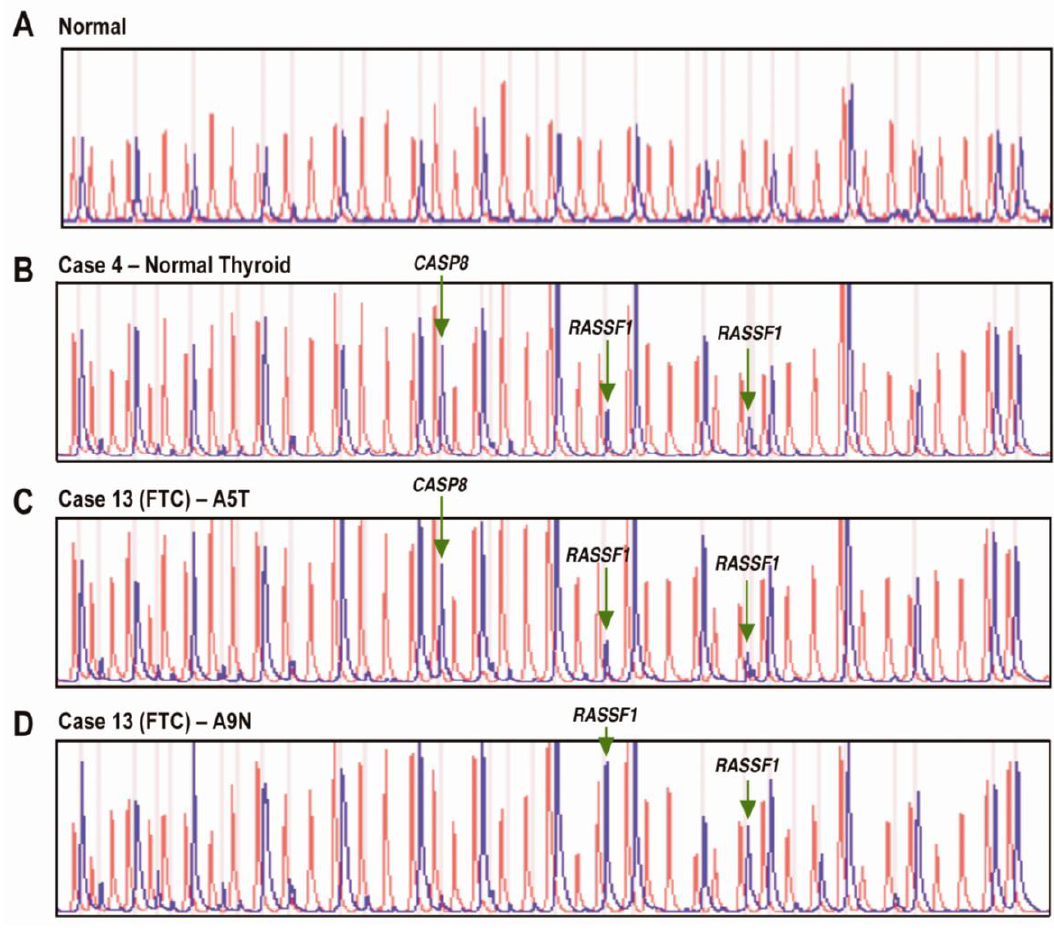
Figure 2. ( A ) Normal control DNA sample with 41 individual peaks (red) in the absence of Hha I and 15 separate peaks (blue) in the presence of Hha I. ( B ) Normal thyroid sample with methylation of CASP8 and RASSF1 . ( C ) Follicular thyroid cancer (Case 13 - tumor block) with methylation of CASP8 and RASSF1 . ( D ) Follicular thyroid cancer (Case 13 - normal block) with methylation of RASSF1 . (FTC – follicular thyroid cancer, A5T – block A5 tumor, A9N – block A9